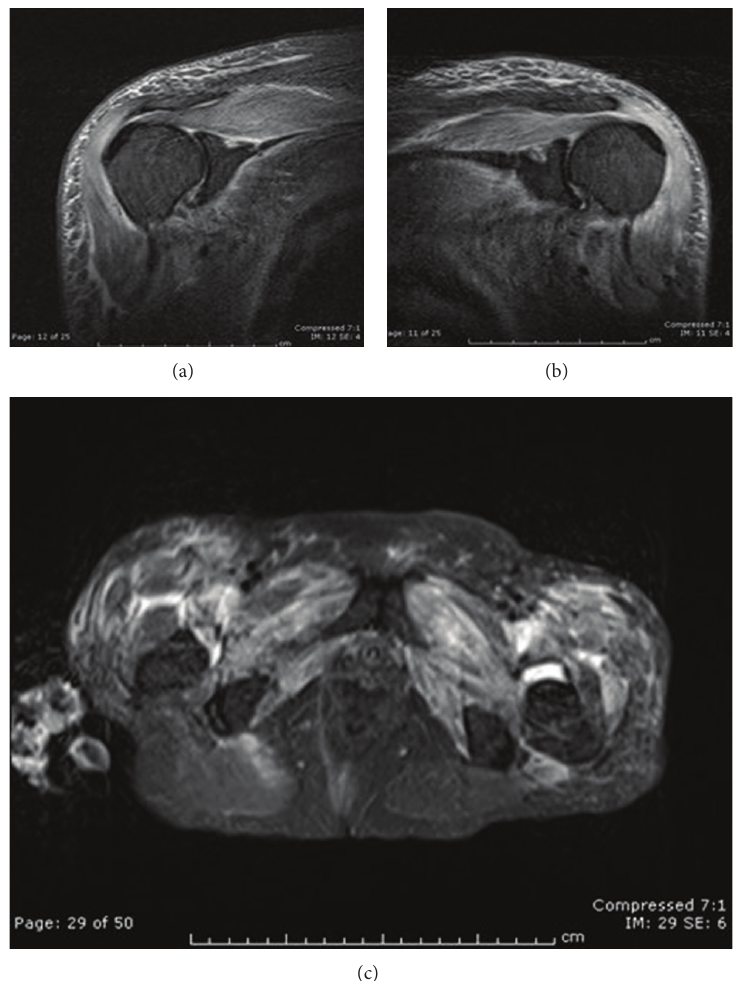
Figure 7: MRI with short tau inversion recovery (STIR) image showing diffuse symmetrical proximal muscle edema. (a) Right shoulder, (b) left shoulder, and (c)